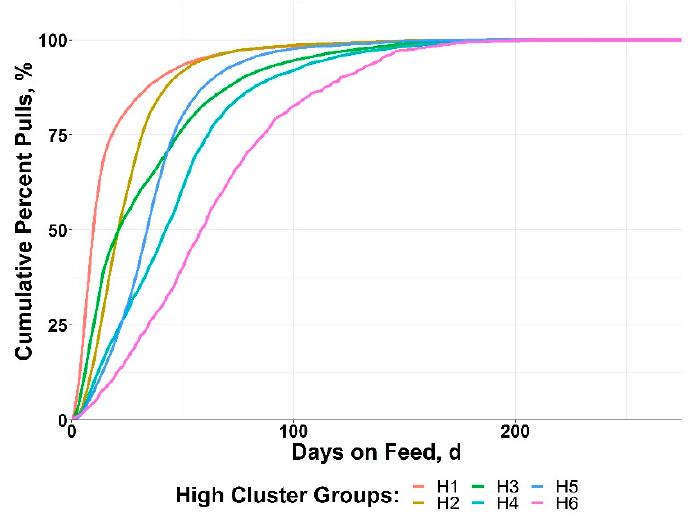
Figure 3. Data from 10 US feedlots were used to perform a cluster analysis of cohorts with ≥ 15% bovine respiratory disease (BRD) morbidity based on the cumulative timing, days on feed